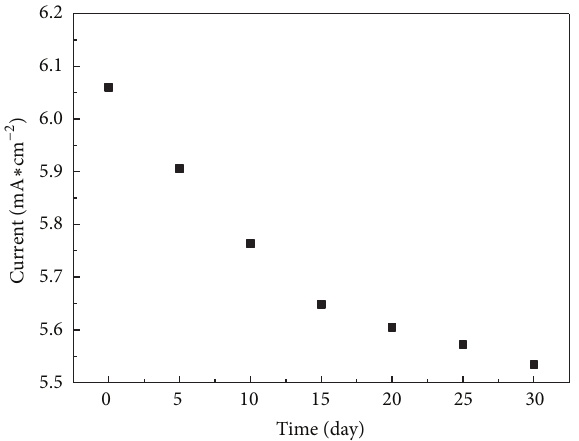
Figure 9: Current response of the Ag-TiO 2 (500 ∘ C) nanotube electrode to 10mM glucose after storing for different